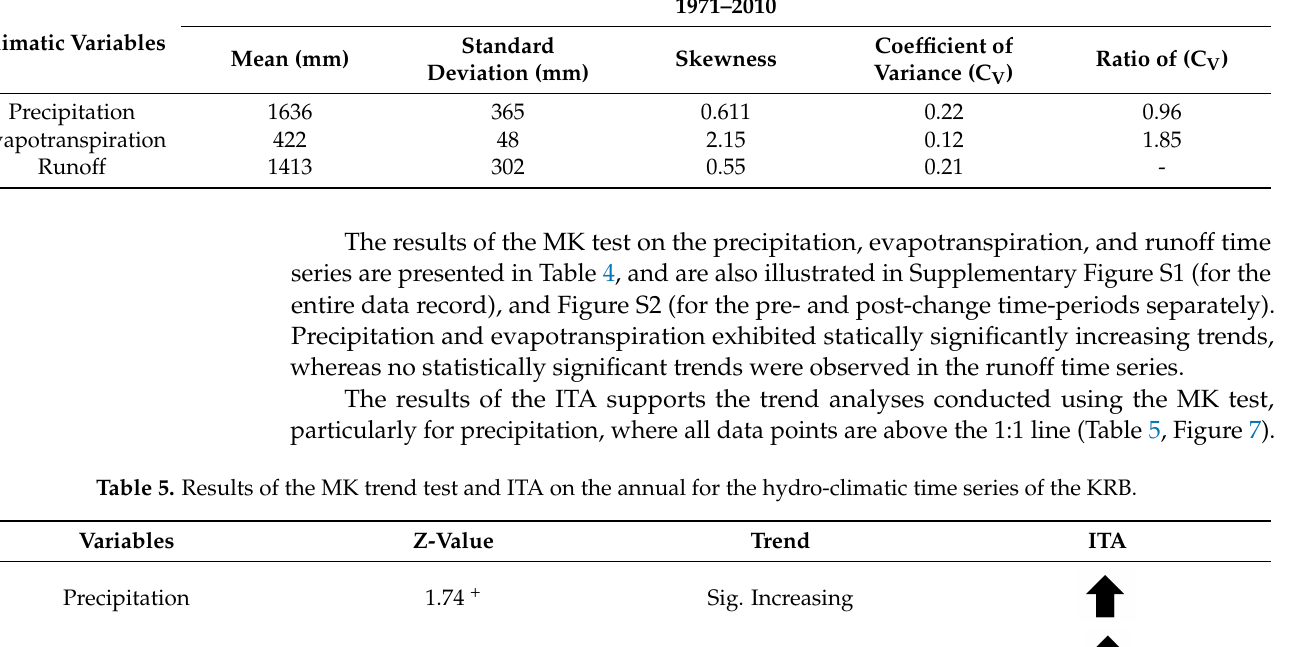
Climatic Variables